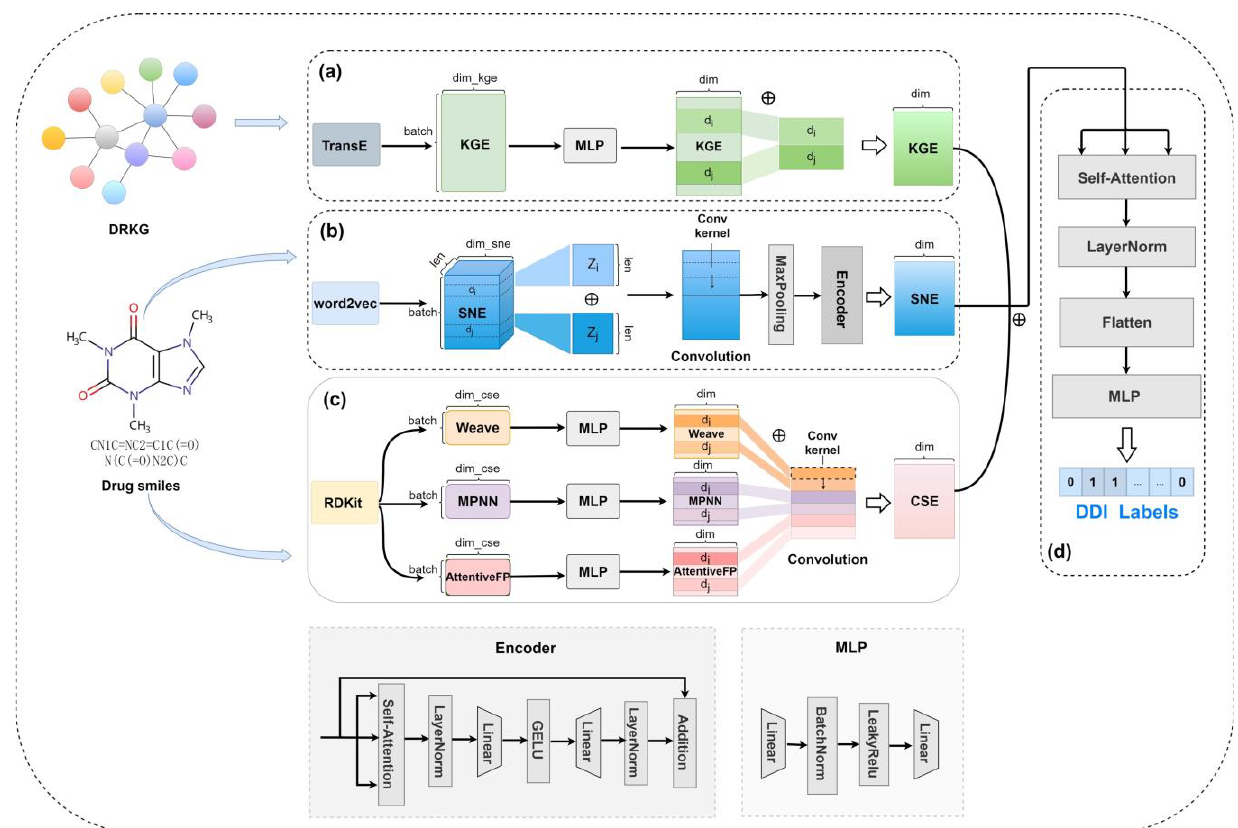
Figure 5. The entire framework of MSEDDI. ( a ) Network channel. MSEDDI applies the graph embedding algorithm TransE to mine the relationship and topological information between drugs and other biomedical identifiers from the biomedical network DRKG as the drug knowledge graph embedding kge . The kge is spliced into the network representation of drug pairs through MLP. ( b ) Sequence channel. We employ the word2vec algorithm to convert the drug SMILES string into SMILES notation embedding sne . MSEDDI splices drug pair sne and processes them into the sequence representation using a convolutional network and encoder module for learning the local and global contexts of the SMILES sequence. ( c ) Graph channel. We utilize three graph neural network algorithms to extract the chemical structure embedding cse of the drug molecular graph acquired by the RDKit tool. Subsequently, MSEDDI sets three MLPs and a convolutional network for generating the graph representation of drug pairs. ( d ) Feature fusion. MSEDDI stacks three highly abstracted drug pair representations to feed into the self-attention module and MLP for downstream DDI prediction